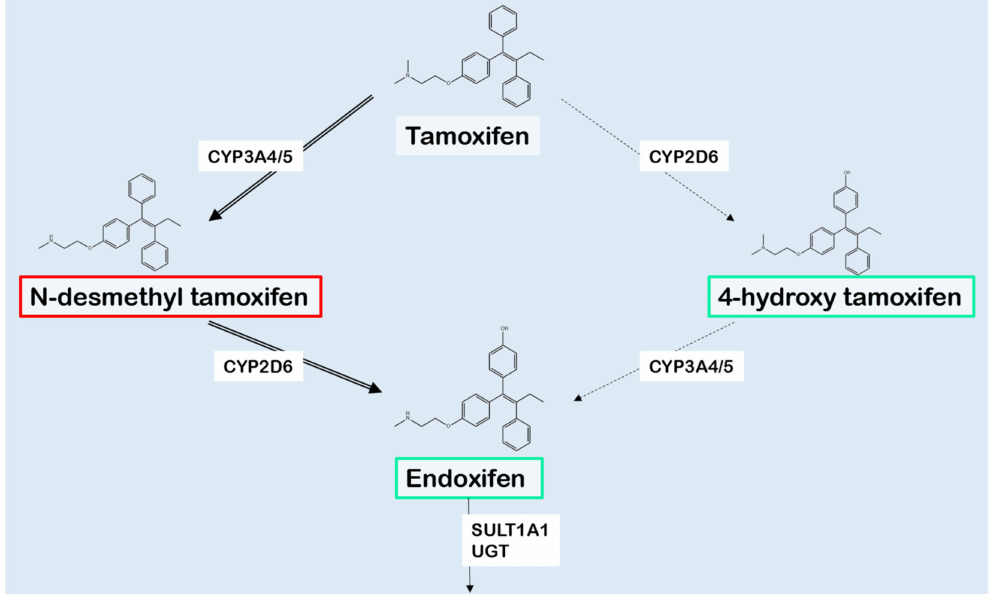
Figure 1. Simplistic representation of the main biotransformation of tamoxifen and its metabolites. The generation of N-desmethyltamoxifen (NDM-TAM) is predominantly catalyzed by CYP3A4/5, whereas especially CYP2D6 is responsible for the formation of 4-hydroxytamoxifen (4OH-TAM) and endoxifen. The activity of metabolites is shown using red to indicate for inactivity and green for activity. The various metabolites are inactivated by UGTs and SULTs, mainly isoform SULT1A1. Abbreviations: CYP: Cytochrome P450 isoenzymes, UGT: UDP-glucuronosyltransferase, SULT: sulfotransferase isoenzyme. Figure based on Jin, et al.